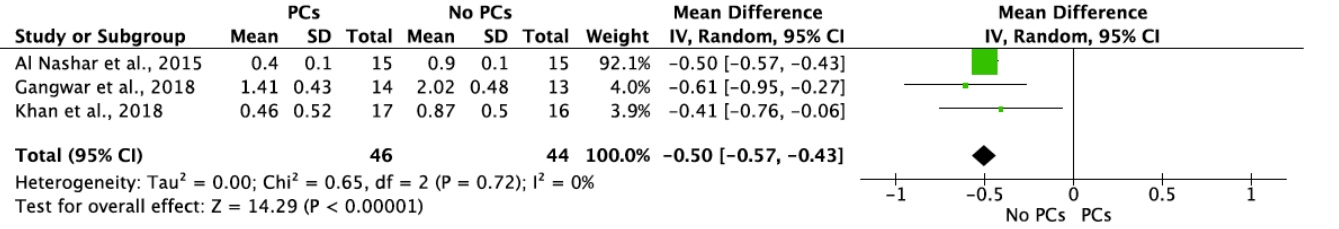
Figure 2. Random-effect meta-analysis evaluating marginal bone loss (MBL) in both aspects at 6 months in immediate implants procedures with PCs vs. no PCs.